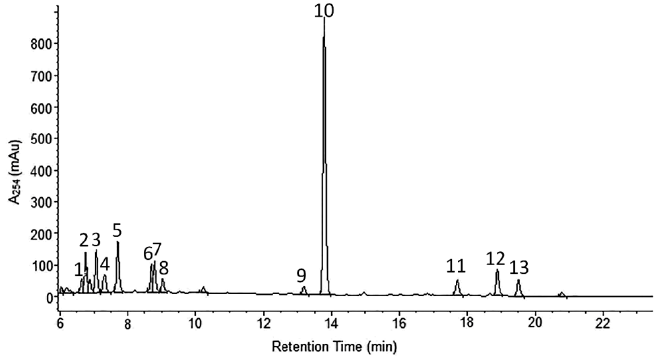
Figure 3. The selected segment of HPLC-DAD chromatogram of the hydro-alcoholic extract (HAE) recorded at 254 nm. Peak assignments (tentative identification): 1. isoschaftoside; 2. schaftoside; 3. vicenin-2; 4. vicenin-3; 5. caffeic acid; 6. isoorientin; 7. isovitexin; 8. swertisin; 9. 1 β ,10 β -epoxydesacetoxymatricarin; 10. leucodin; 11. 5-demethylsinensetin; 12. 2-(3,4-dimethoxy-phenyl)-3-hydroxy-5,6,7-trimethoxy- chromen-4-one; 13. salvigenin.